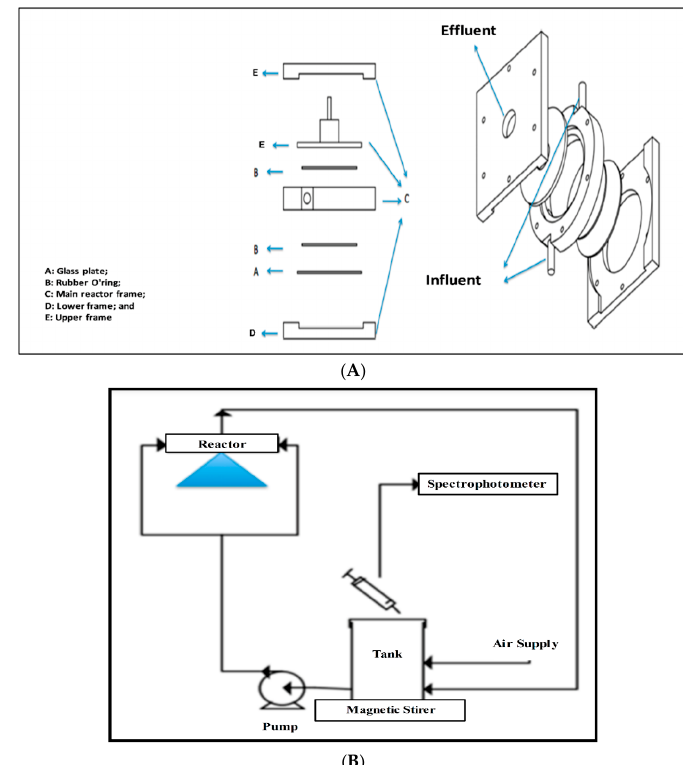
Figure 14. ( A ) Details (components and parts) of the swirl flow reactor used in the study. ( B ) Experimental setup (Adopted from [36] with proper modifications). setup (Adopted from [36] with proper